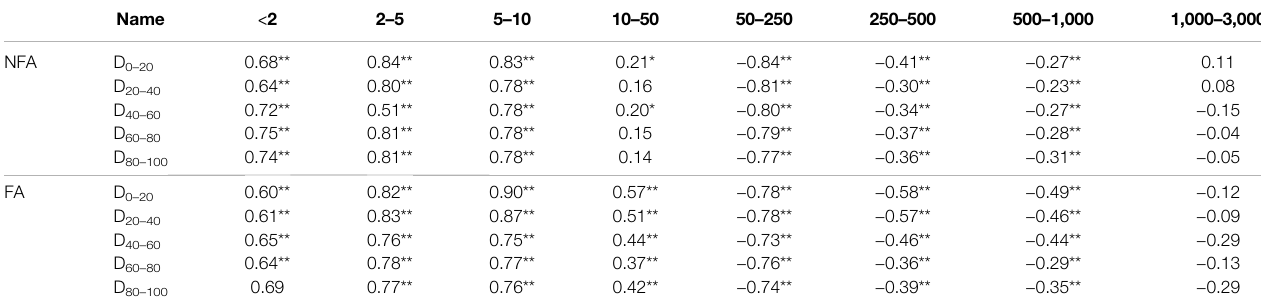
TABLE 2 | Correlation analysis between the soil particles and D in the farmland in the fl ooded area (FA) and the non fl ooded area